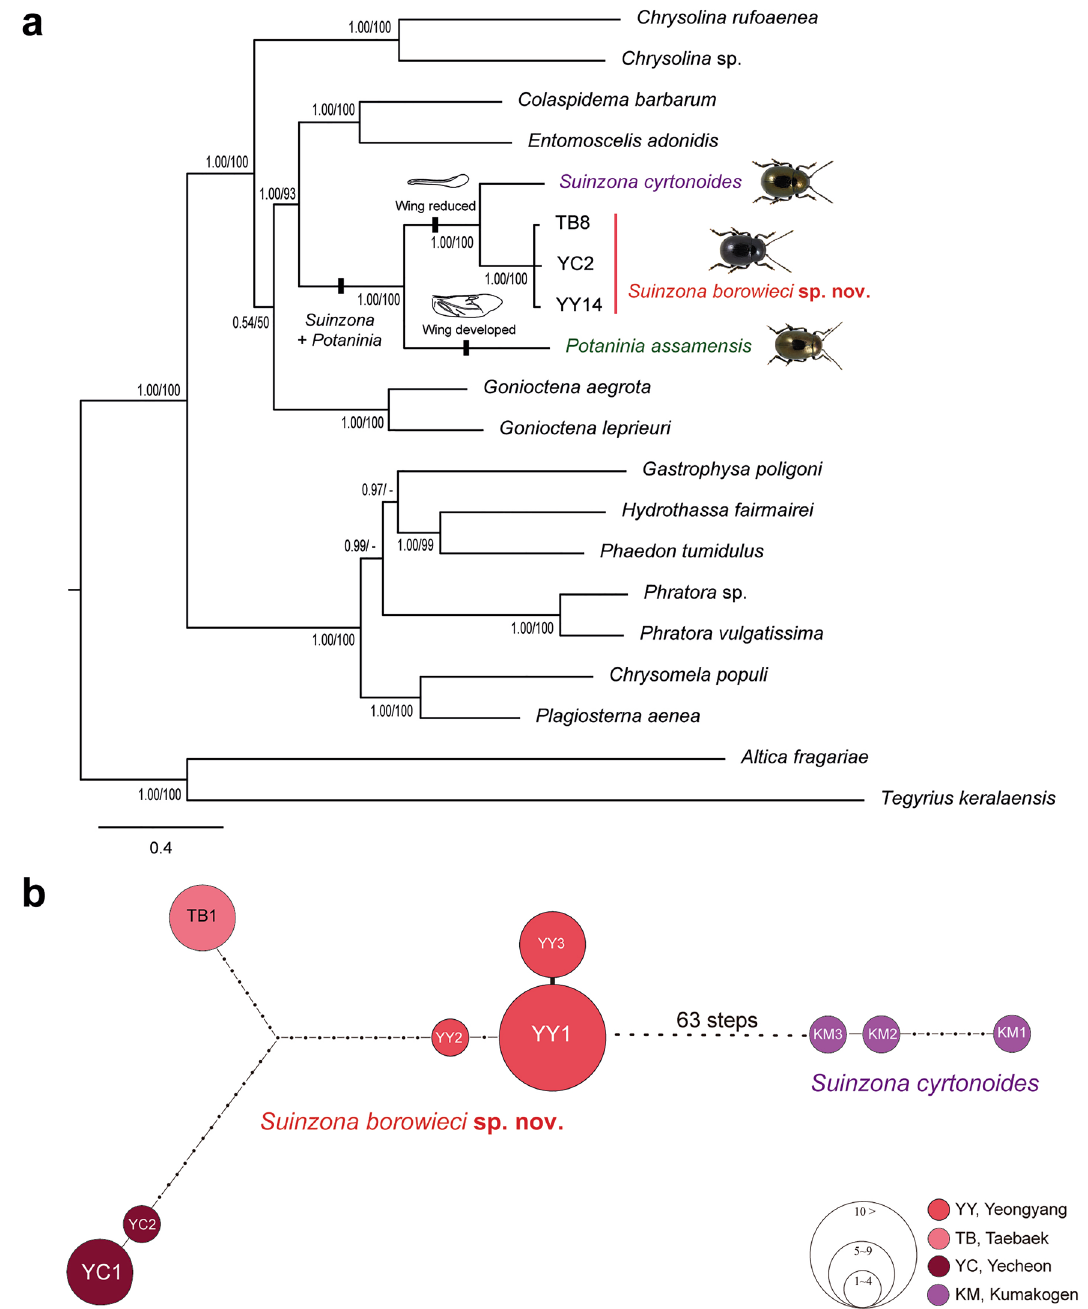
Figure 7. Phylogenetic tree and parsimonious network: ( a ) Bayesian consensus tree inferred from the combined mitochondrial 13 PCGs + 2 rRNA gene. Bayesian inference (left) and maximum likelihood (right) support values are shown on the branch nodes. Only the values over 70% are reported, ( b ) Parsimonious network of COI haplotypes. Circles correspond to haplotypes, the frequency and geographic origin of which are indicated by circle size. The geographical origins of the haplotypes are noted at the bottom right of the